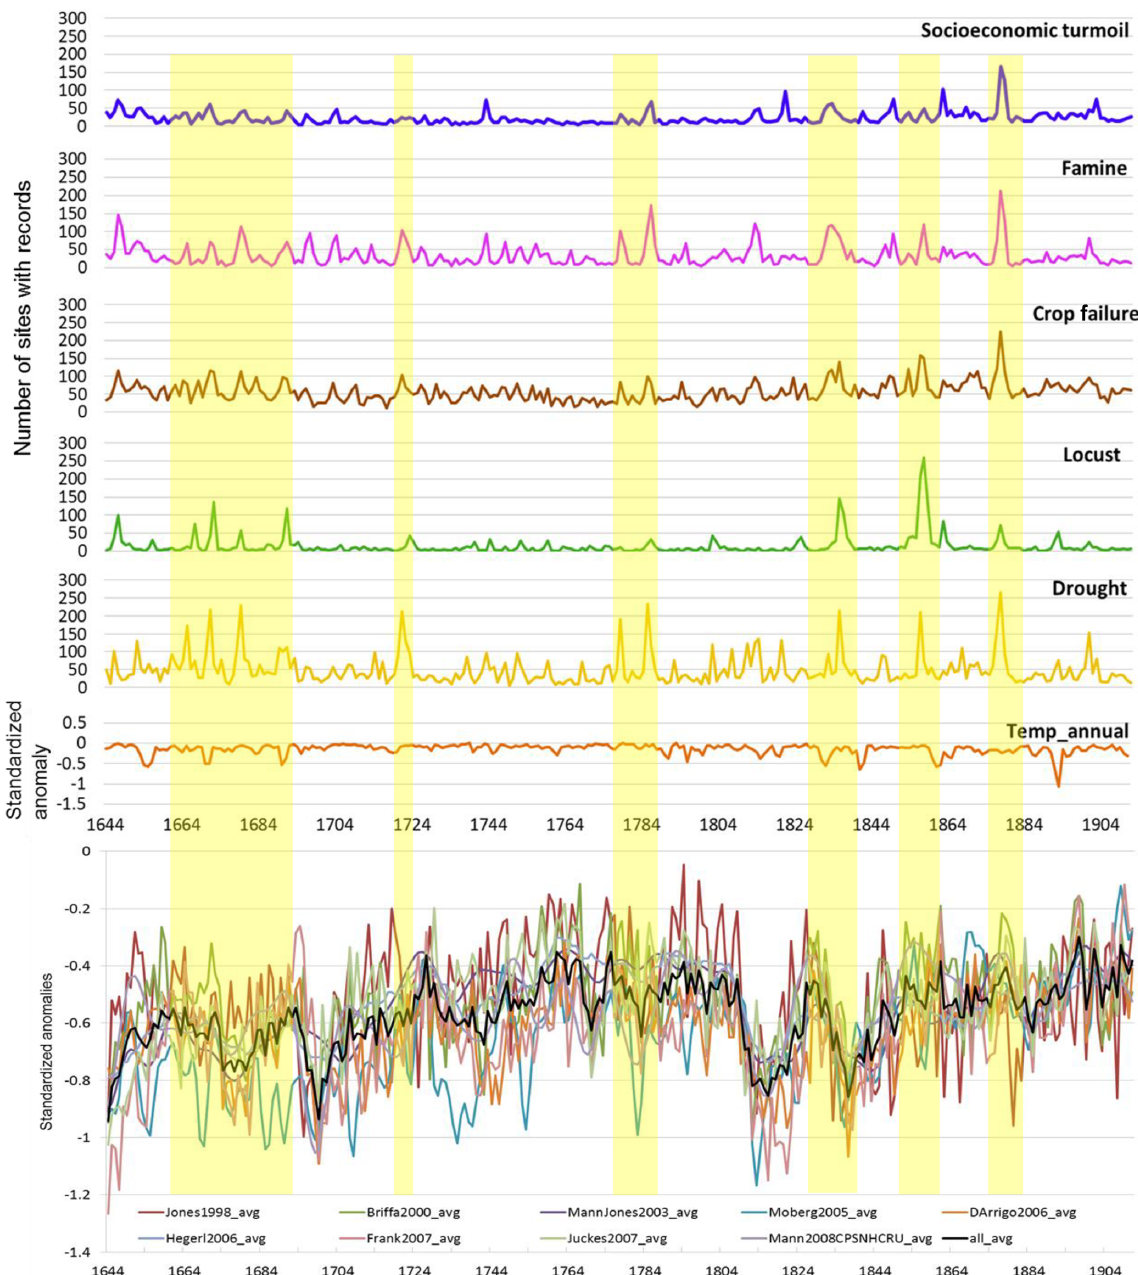
Figure 4. Time series plots of socioeconomic turmoil, famine, crop failure, locust, drought, and the Chinese monsoonal annual temperature anomaly reconstructed from REACHES. The bottom panel shows assembled Northern Hemisphere temperature anomalies from Frank et al. (2010). Periods with more frequent drought records are highlighted in yellow